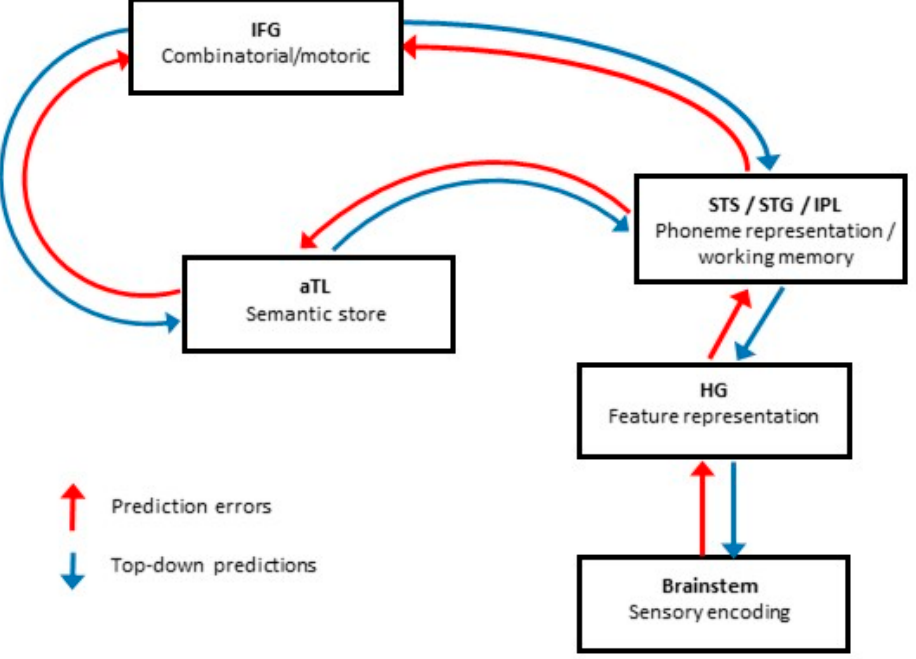
Figure 1. A predictive coding model of normal degraded speech processing with major anatomical loci for core speech decoding operations and their connections, informed by evidence in the healthy brain. Different kinds of degraded speech manipulation are likely to engage these cognitive operations and connections differentially (see Table 1). Incoming sensory information undergoes “bottom-up” perceptual analysis chiefly in early auditory areas, while higher level brain regions generate predictions about the content of the speech signal. Boxes indicate processors that instantiate core functions; note, however, that processing “levels” are not strictly confined to higher-order predictions or early sensory input: interactions occur at each level. Arrows indicate connections between levels, with reciprocal information flow mediating modulatory influences and dynamic updating/perceptual learning of degraded speech signals. This figure is necessarily an over-simplification; cortical areas that are likely to have separable functional roles are grouped together for clarity of representation, and while they are not shown in this figure, intra-areal recurrences and inhibitions alongside other local circuit effects may also be operating within these regions. aTL, anterior temporal lobe; HG, Heschl’s gyrus; IFG, inferior frontal gyrus; IPL, inferior parietal lobule; STG, superior temporal gyrus; STS, superior temporal